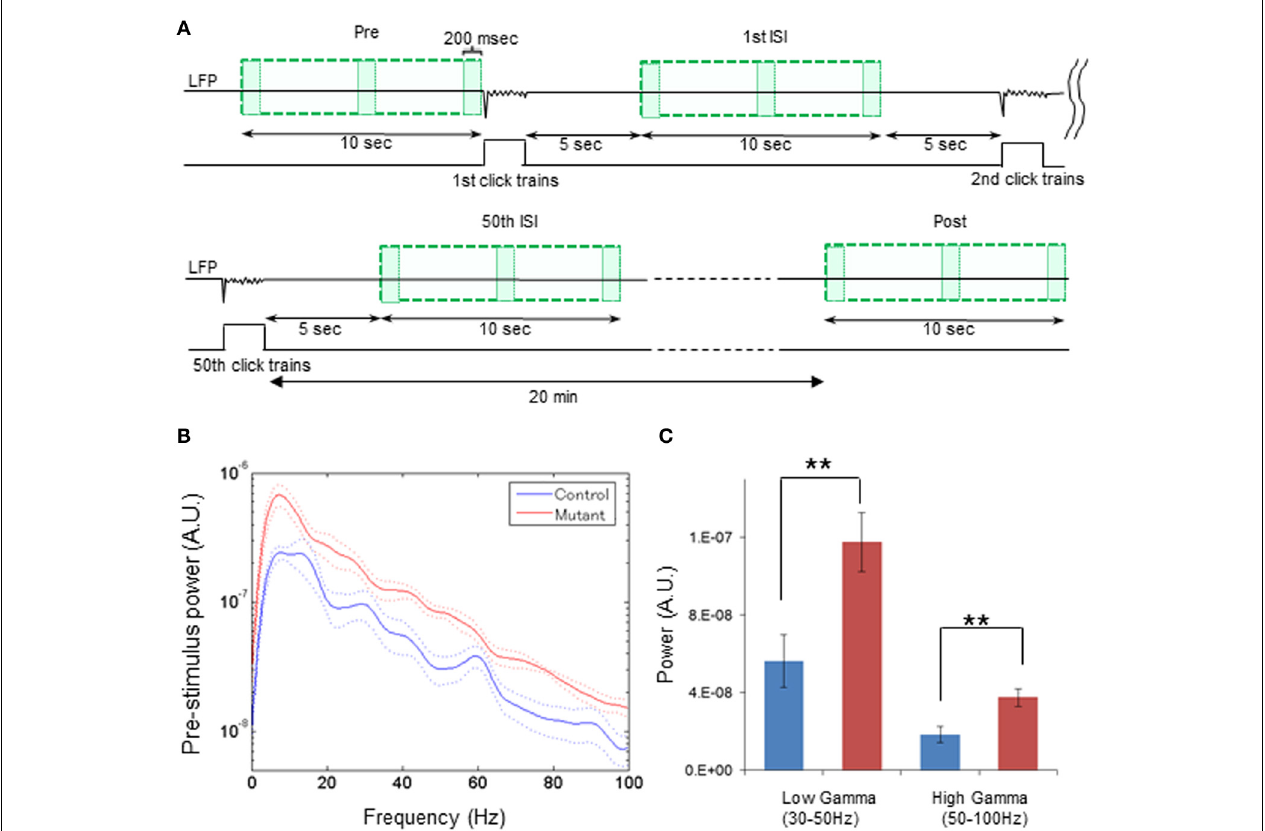
FIGURE 3 | Broadband elevation of mutant spontaneous LFP power during pre-stimulus period. (A) Schematic diagram indicates the analysis periods of spontaneous LFP power during pre-stimulus period (Pre), following the first ASSR stimuli [1st inter-stimulus interval (ISI)], following the 50th ASSR stimuli (50th ISI), and during post-stimulus period (Post). For a pre-stimulus period, z-score normalized LFPs (top line) during last 10s (upper left green square) before the first click train onset were analyzed with FFT algorism with every 200-ms bin (each box). During ASSR sessions, LFP data from 5 to 15s (200-ms bin) after the 1st stimuli (upper right green square), the 25th stimuli (not shown), and 50th stimuli (bottom left green square)